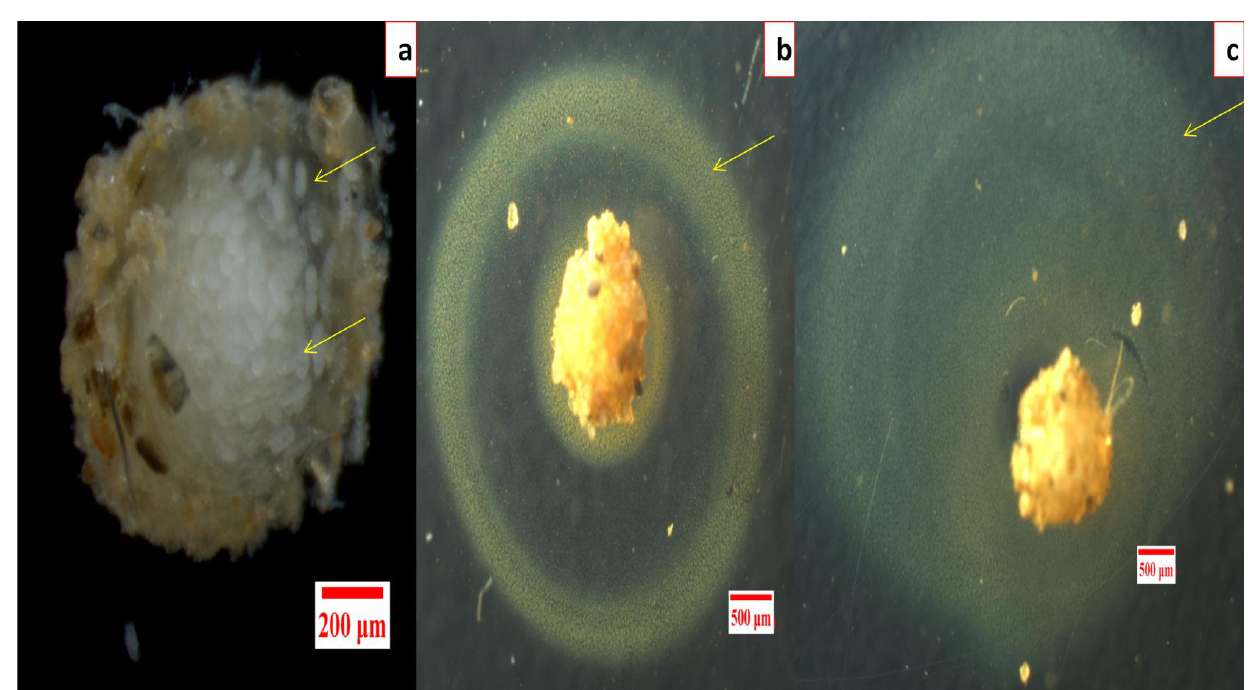
Figure 4. Effect of silver nanoparticles synthesized using aqueous root extract of G. glabra (GRAgNPs) on hatching inhibition in M. incognita, ( a ) healthy egg mass, ( b ) GRAgNPs treated egg mass after 24 h, ( c ) after 48 h of the treatment .